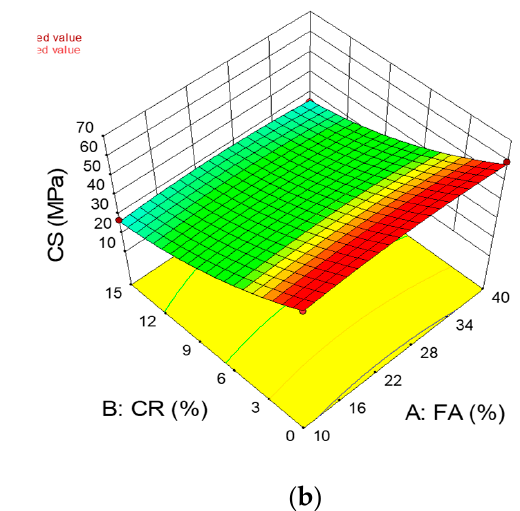
Figure 15. ( a ) 2D contour plot and ( b ) 3D response surface diagram for CS.